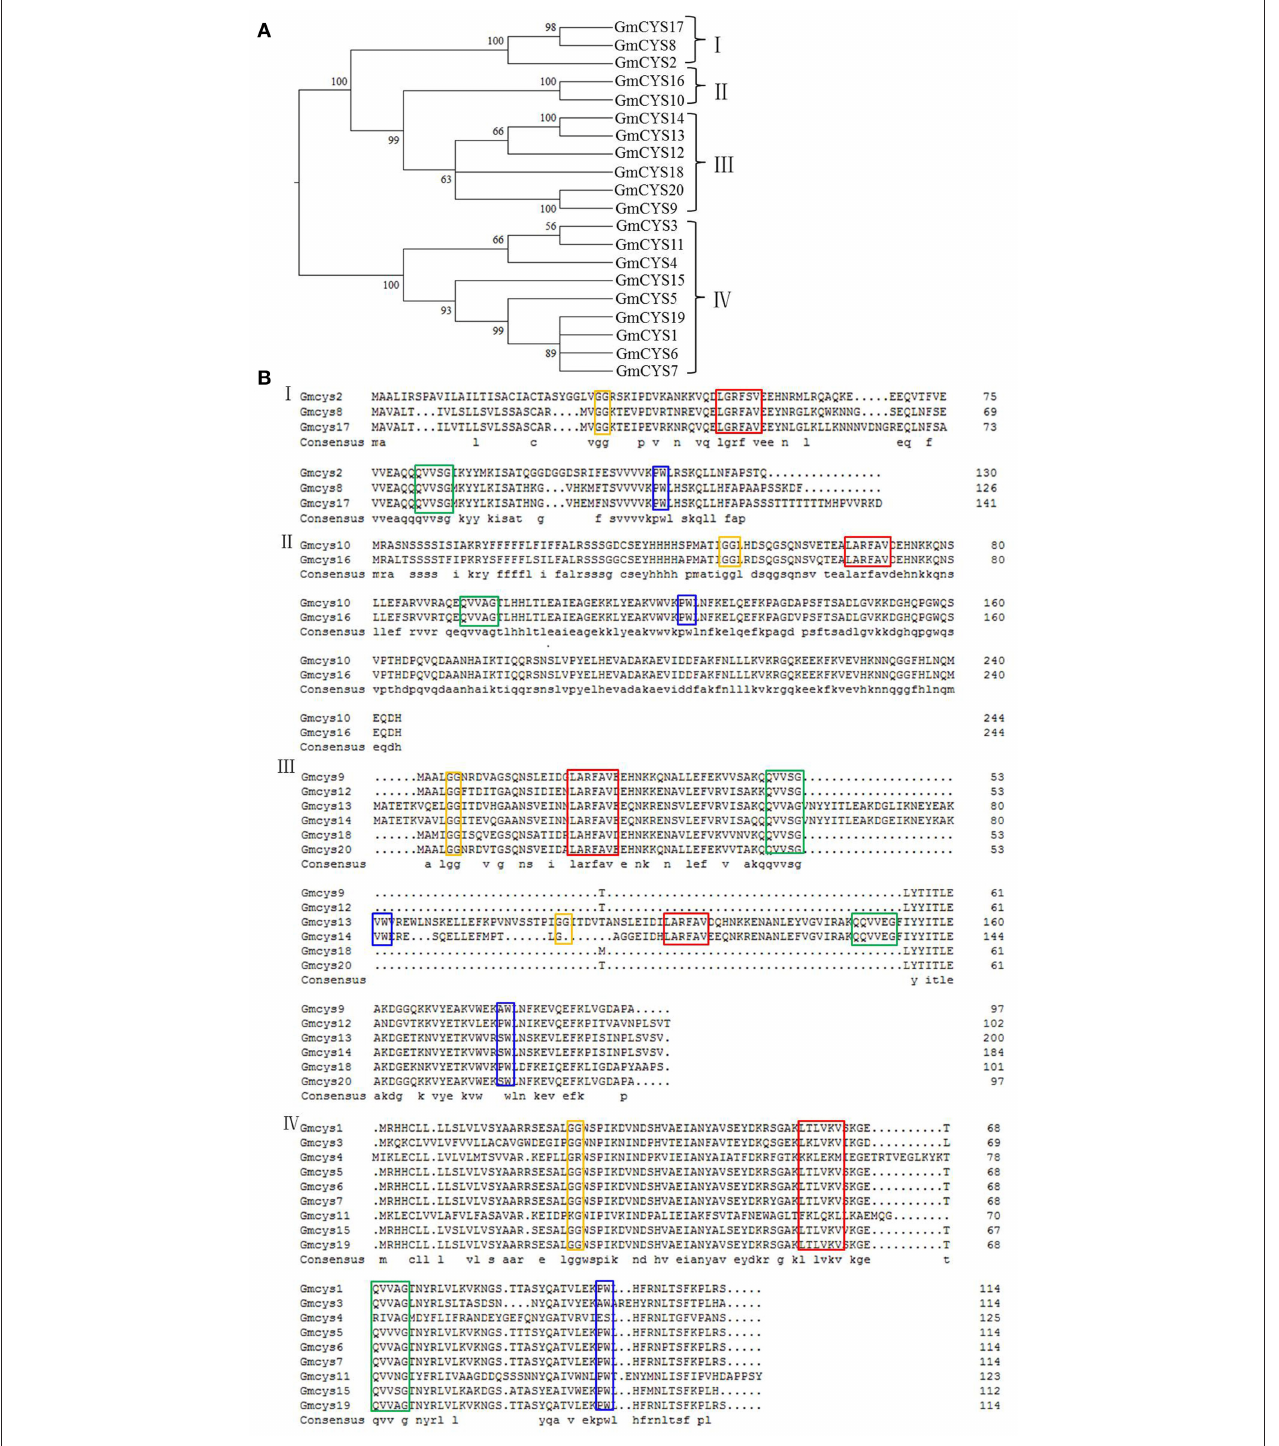
FIGURE 1 | Phylogenetic analysis and amino acid residue alignment of soybean cystatins. (A) Phylogenetic analysis of soybean cystatins. Phylogenetic tree construction of soybean cystatins is based on the full-length deduced amino acid sequences using MEGA 6 by the neighbor-joining method with 1000 bootstrap replicates. The tree shows four major phylogenetic clades (clades I to IV) indicated with braces. (B) Alignments of conserved motifs of different clades of the soybean cystatins. The main cystatin conserved motifs in four phylogenetic clades (clades I to IV) are in orange, red, green, and blue boxes.